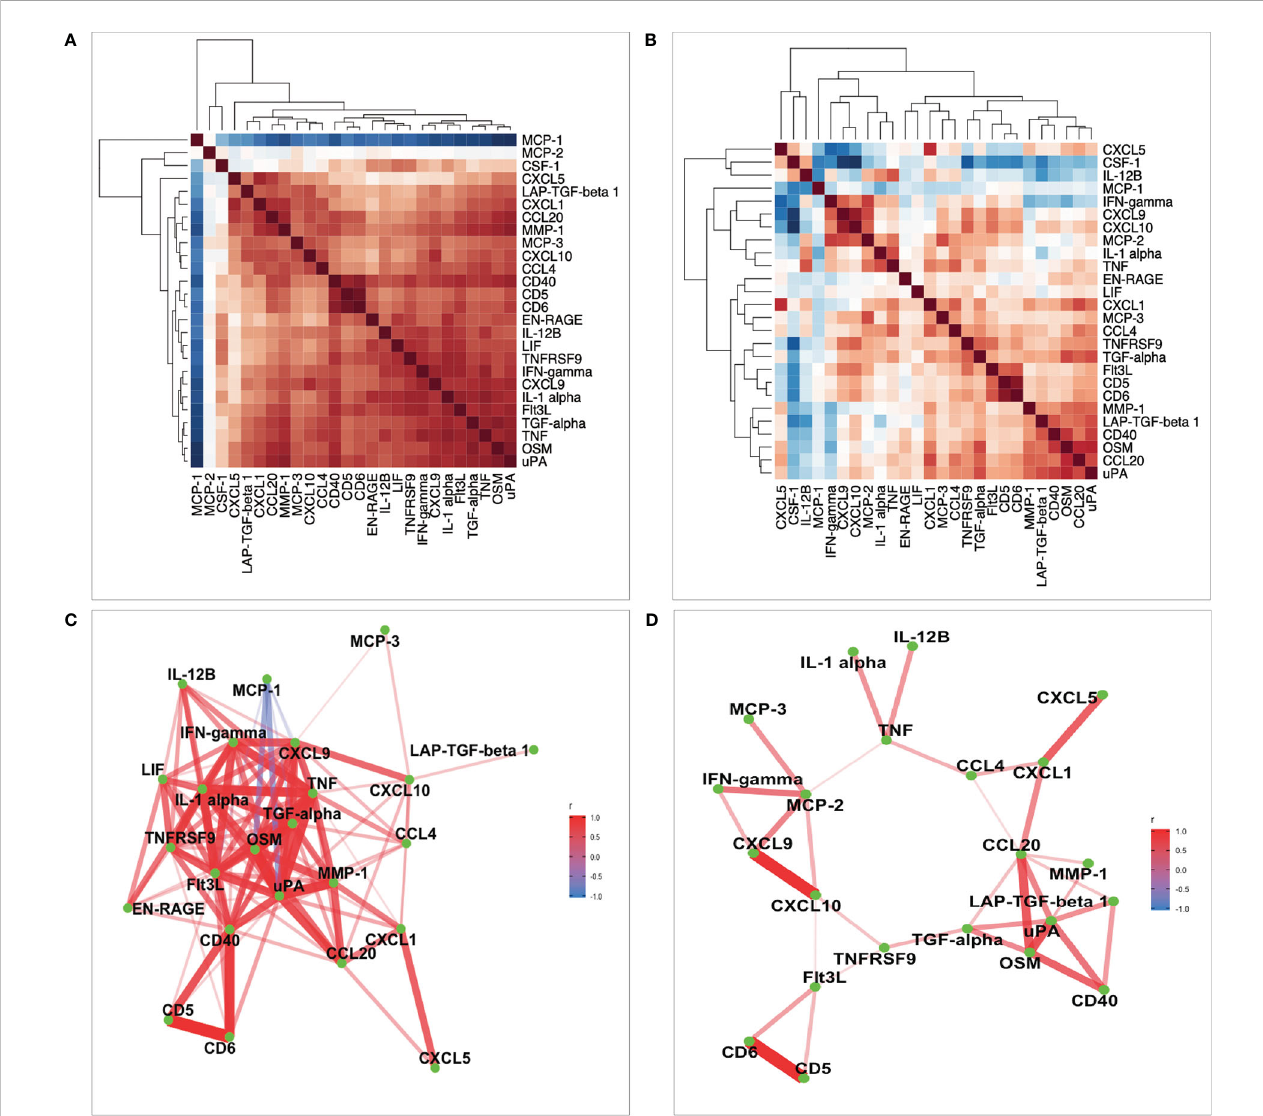
FIGURE 4 Heatmaps of correlation analysis. (A, B) Correlation of 26 common proteins for the 500FG and 1M-scBloodNL cohorts respectively. Pairwise correlation between proteins were computed using residual values after adjusting age and sex on protein levels. (C, D) Represents network of proteins with strong pairwise correlation coef fi cients for the 500FG and 1M-scBloodNL cohorts